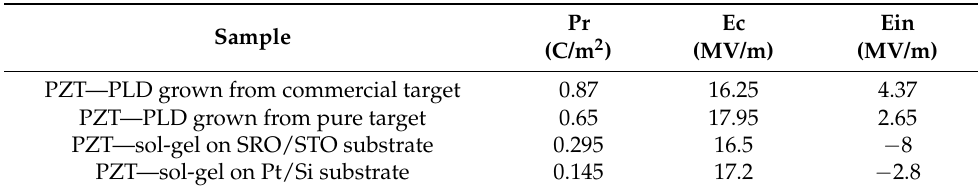
Figure 4. ( a , b ) Polarization-voltage characteristics obtained for different amplitudes of the volt- age pulse. ( c , d ) Specific capacitance obtained from the derivative of polarization-voltage loops. ( e , f ) Representation of the maximum values of the specific capacitance and of the current at max- imum voltage as a function of amplitude of the voltage pulses. The results from the first column are attributed to polycrystalline PZT film deposited by spin-coating on the SRO/STO single crystal substrate (SRO deposited by PLD) and from the second column are attributed to polycrystalline PZT film deposited by spin-coating on Pt-coated Si substrate. Table 1. Values of remnant polarization Pr, coercive field Ec and internal electric field Ein for the PZT films of different structural